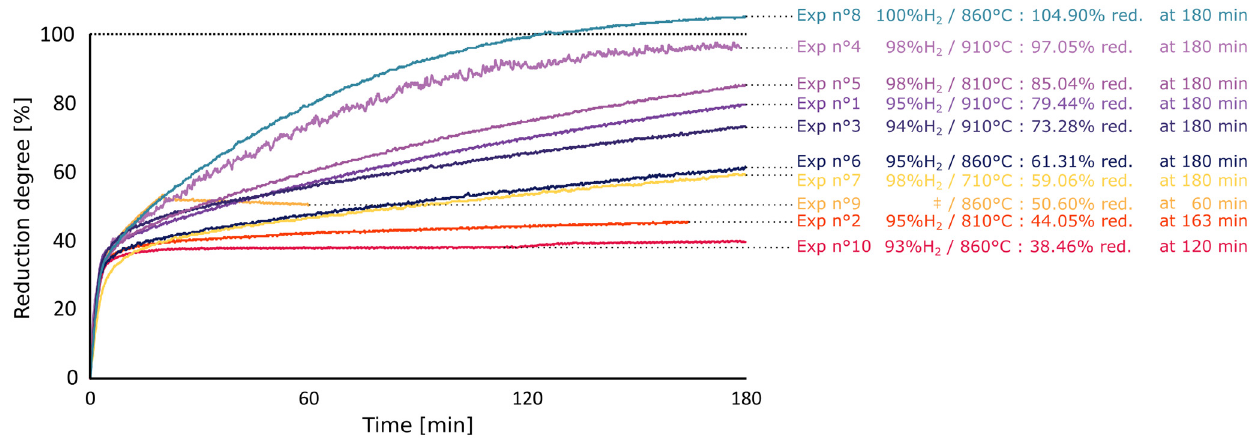
Figure 4. Reduction degree as a function of time for the experiments of the study. ‡: (from 100/0 H 2 /H 2 O and 7.44 L/min to 93/7 H 2 /H 2 O and 8 L/min).